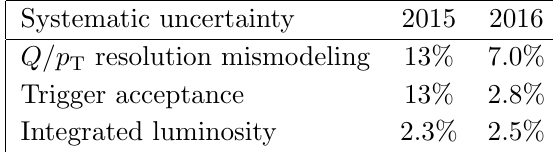
Table 6 . Systematic uncertainties in the signal e(cid:14)ciency for the 2015 and 2016 muon searches. There is also a systematic uncertainty associated with the trigger acceptance. Since the largest di(cid:11)erence between data and MC simulation in the plateau of the trigger turn- on curves is 13 (2.8)% in the 2015 (2016) analysis, we take these values as the systematic uncertainty in the trigger